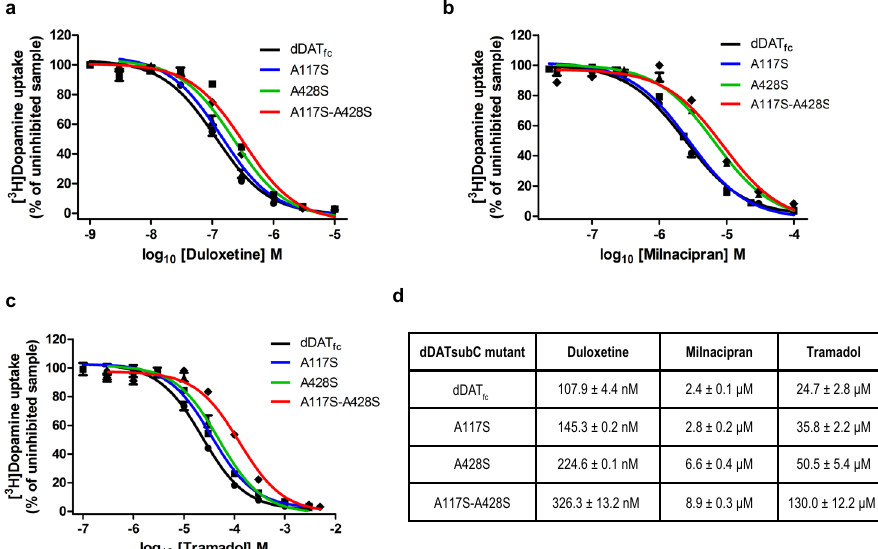
Fig. 6 hDAT-like mutagenesis of residues leads to reduced af fi nities of NET-speci fi c inhibitors. a Dose – response curves of [ 3 H] dopamine uptake inhibition by duloxetine with a functional construct of dDAT carrying hDAT-like mutations in the primary binding site including dDAT functional construct (dDAT fc ) (black), A117S (blue), A428S (green), and A117S/A428S double mutant (red). The uptake inhibition curves of subsite C mutants were compared with that of the dDAT fc (black) plots shown in previous fi gures. b , c Similar uptake inhibition curves plotted using milnacipran and tramadol, respectively. Experimental plots for all mutants are means of n = 9 measurements obtained over three independent experiments and error bars representing s.e.m. d Table indicates IC 50 values ± s.e.m of individual mutant inhibition curves with all three inhibitors. Substitution of subsite C residues A428S and double mutant A117S and A428S display maximal loss of af fi nity for SNRIs duloxetine, milnacipran, and tramadol. The loss in inhibition potencies is signi fi cant ( p values for duloxetine, milnacipran, and tramadol are 2.44 × 10 − 8 , 6.03 × 10 − 10 , and 1.43 × 10 − 5 , respectively) between the dDAT fc and the dDAT A117S- A428S mutant. A two-tailed t test assuming unequal variances was performed to obtain the p values. Source data are provided as a Source Data fi